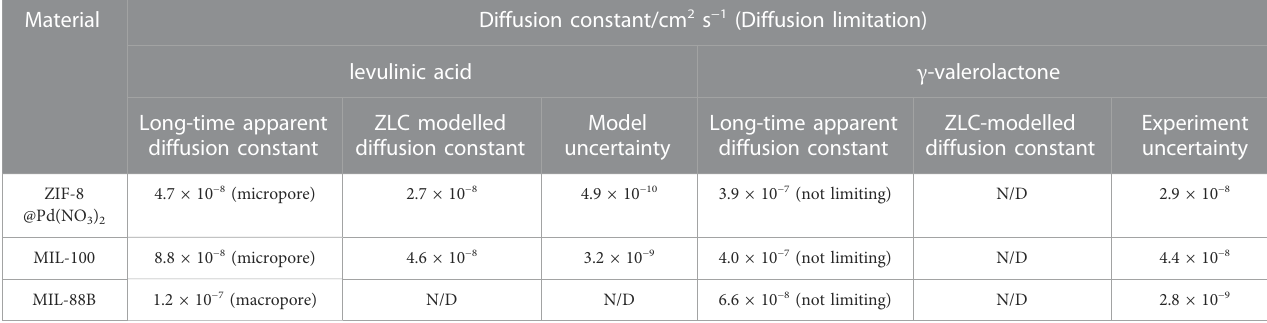
TABLE 2 Zero-length column experimental and modelled diffusion constants for LA and GVL at .5 mL min − 1 , 80 ° C.